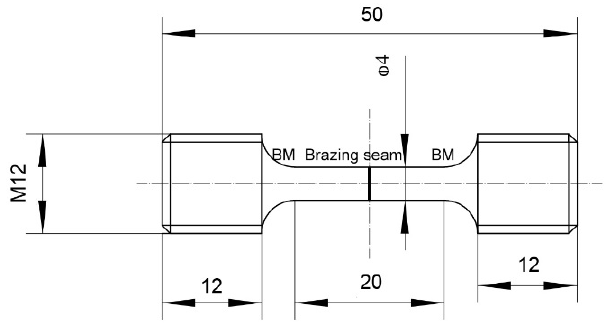
Figure 1. Drawing of a specimen for creep